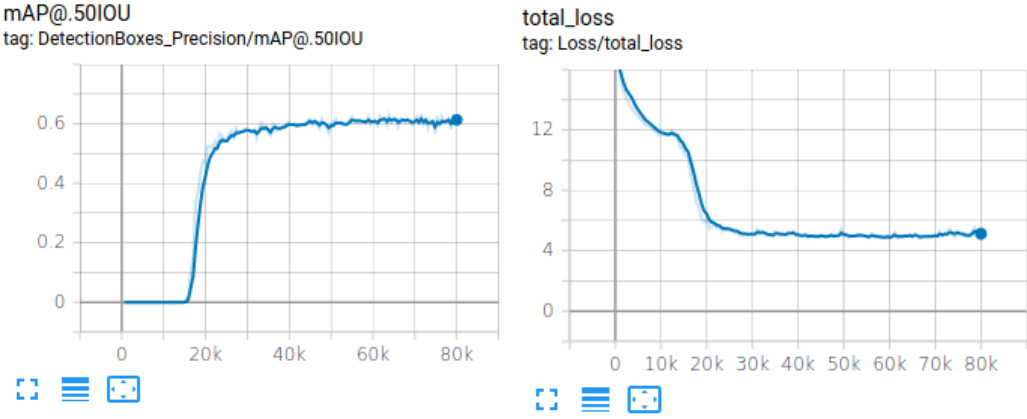
Figure 4. mAP graph and the corresponding training loss graph for Single Shot Multibox Detector (SSD) MobileNet. The model learns the data, while achieving a high accurac at about 80,000